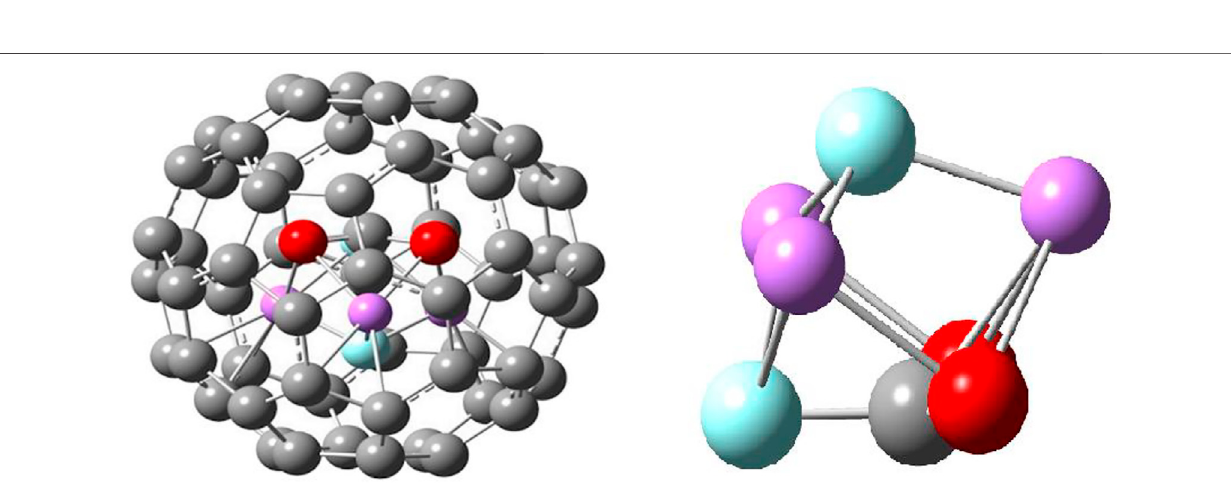
Frontiers in Physics |